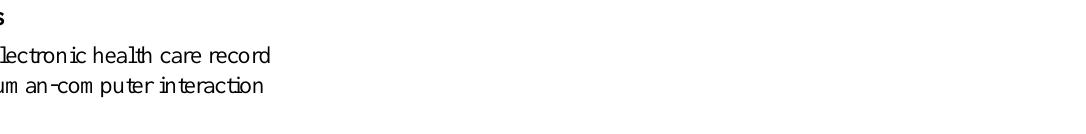
Abbreviations EHR: electronic health care record HCI: human-computer